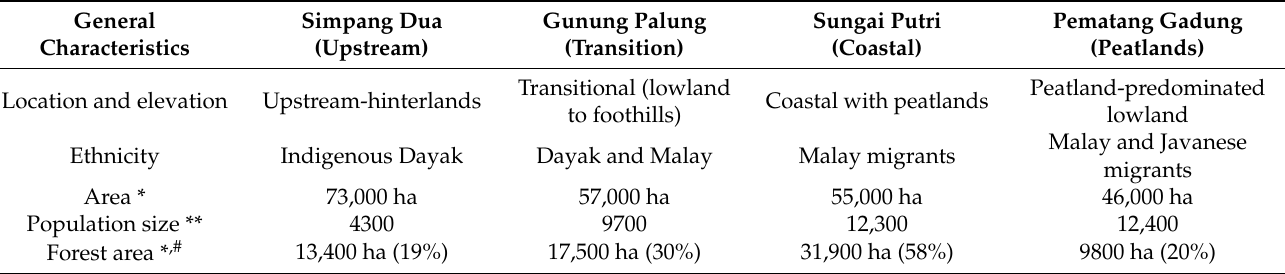
Table 1. Landscape general